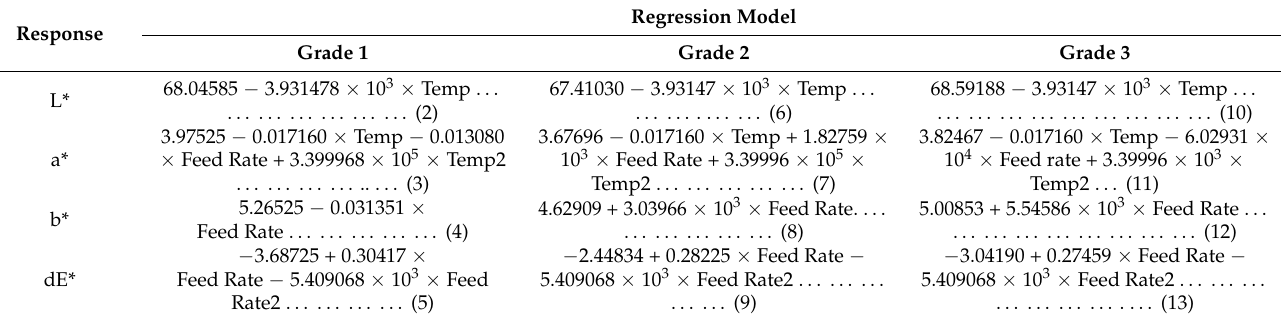
Table 5. Simulate regression